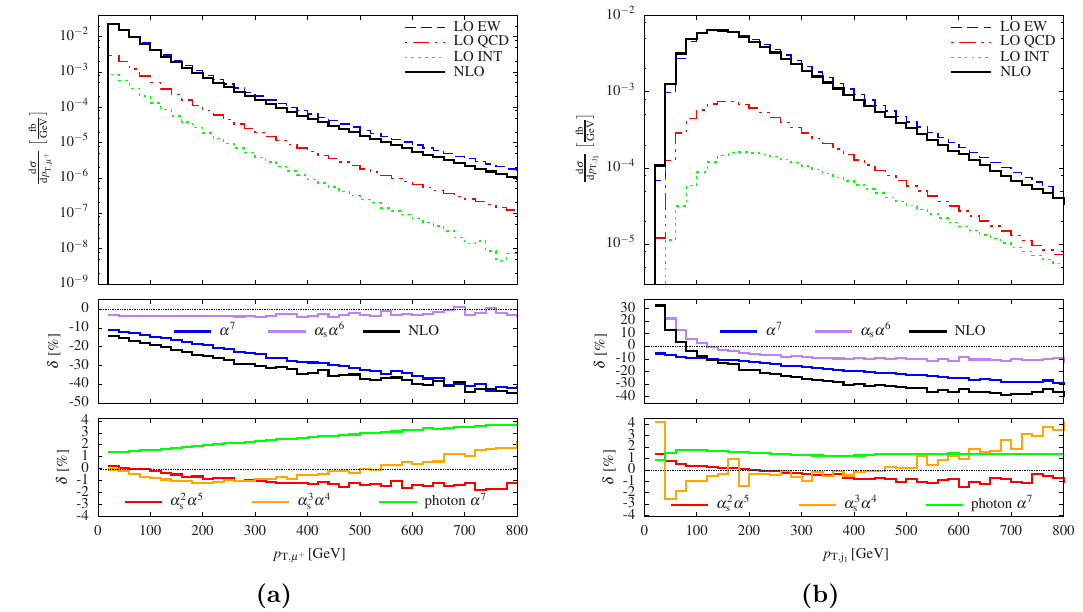
Figure 5. Transverse-momentum distributions at a centre-of-mass energy p s = 13 TeV at the LHC for pp (cid:22) + (cid:23) (cid:22) e + (cid:23) e jj: (a) for the anti-muon (left) and (b) the hardest jet (right). The upper panels ! show the three LO contributions as well as the sum of all NLO predictions. The two lower panels show the relative NLO corrections with respect to the full LO, de(cid:12)ned as (cid:14) i = (cid:14)(cid:27) i =